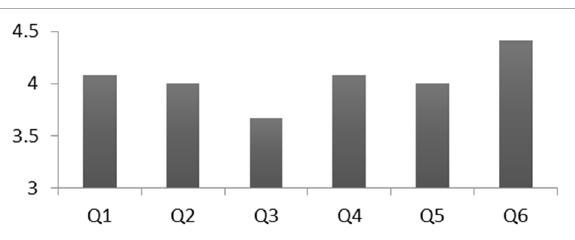
Figure 21. Average ratings of participants’ attitude regarding the UI’s visual aesthetic elements of the proposed app.